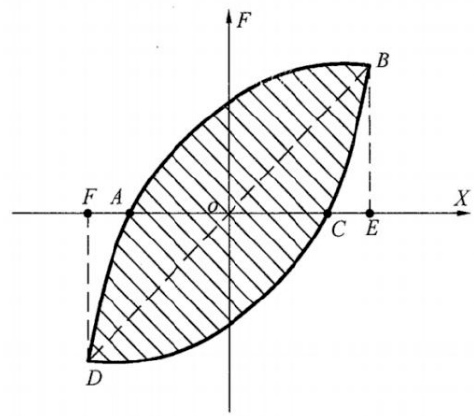
Figure 12. Calculation diagram of equivalent viscous damping coefficient. Table 4. Hysteresis loop area of welded seamless steel tube dampers.